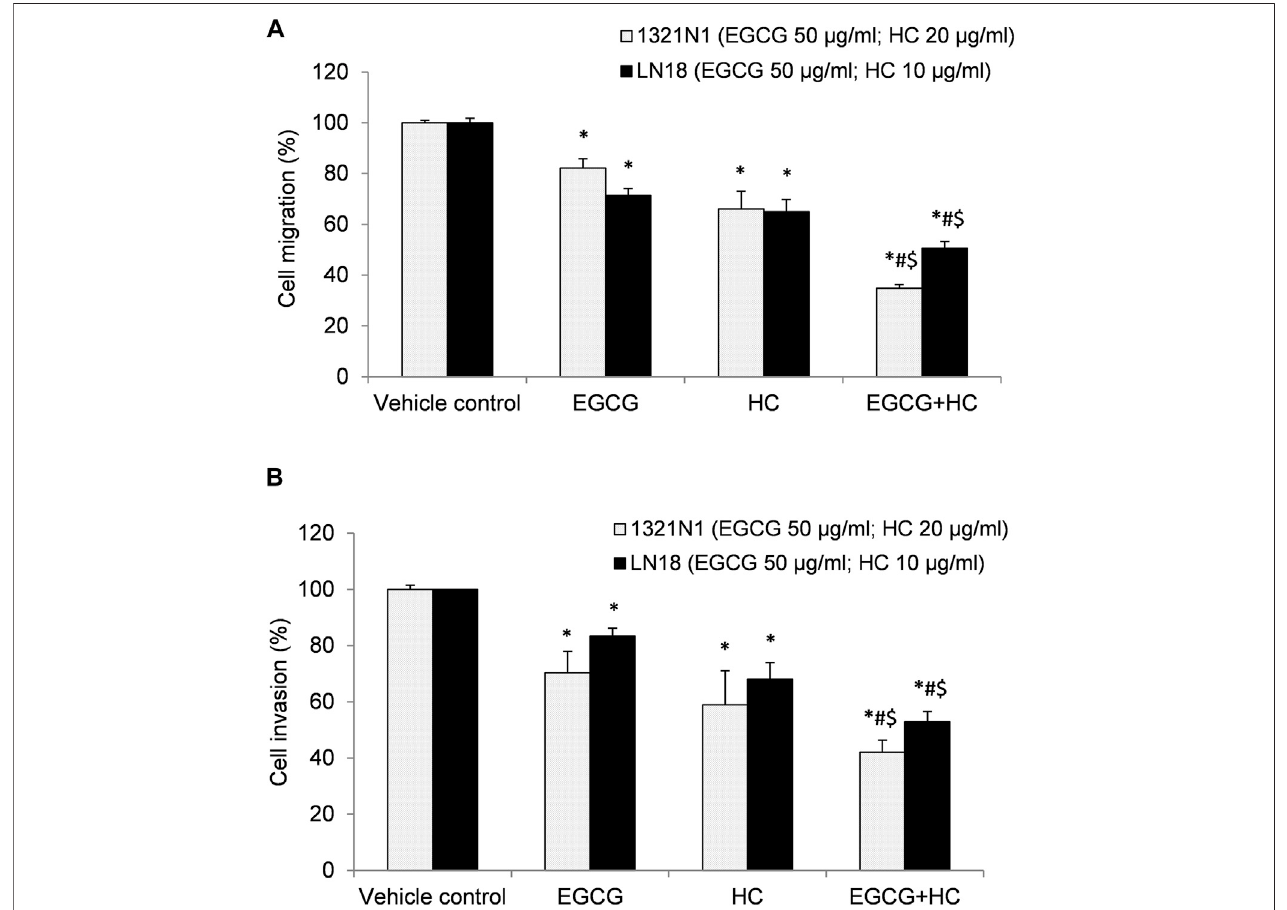
FIGURE 8 | (A) Cell migration, and (B) cell invasion of 1321N1 and LN18 treated with EGCG+HC. The proportion of cell migration/invasion was represented as a percentageofthevehiclecontrol.Eachbarre fl ectsthemean±SDdeterminedfromthreeindependentexperiments.* p < 0.05comparetocontrol,# p < 0.05compareto EGCG, $ p < 0.05 compare to